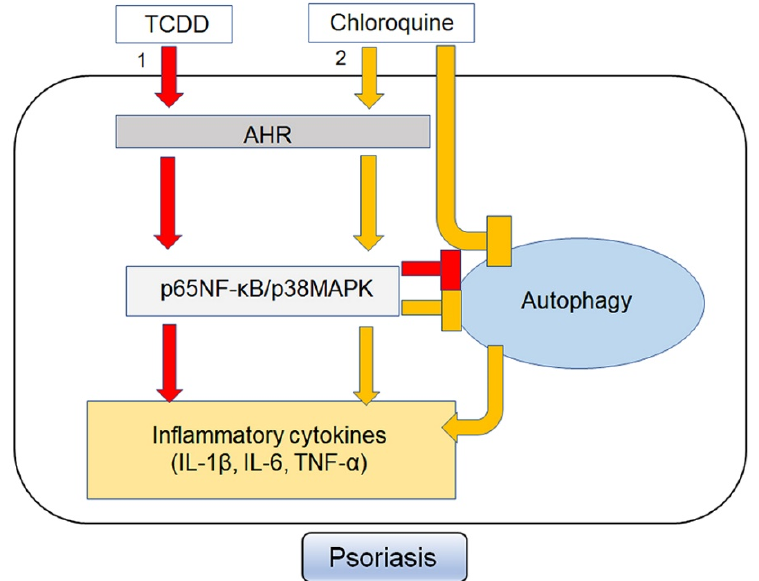
Figure 10. Suggested mechanism of AhR activation and autophagy on the pathogenesis of psoriasis. 1. AhR activation by TCDD suppress autophagy, contributing to skin inflammation via the p65NF-